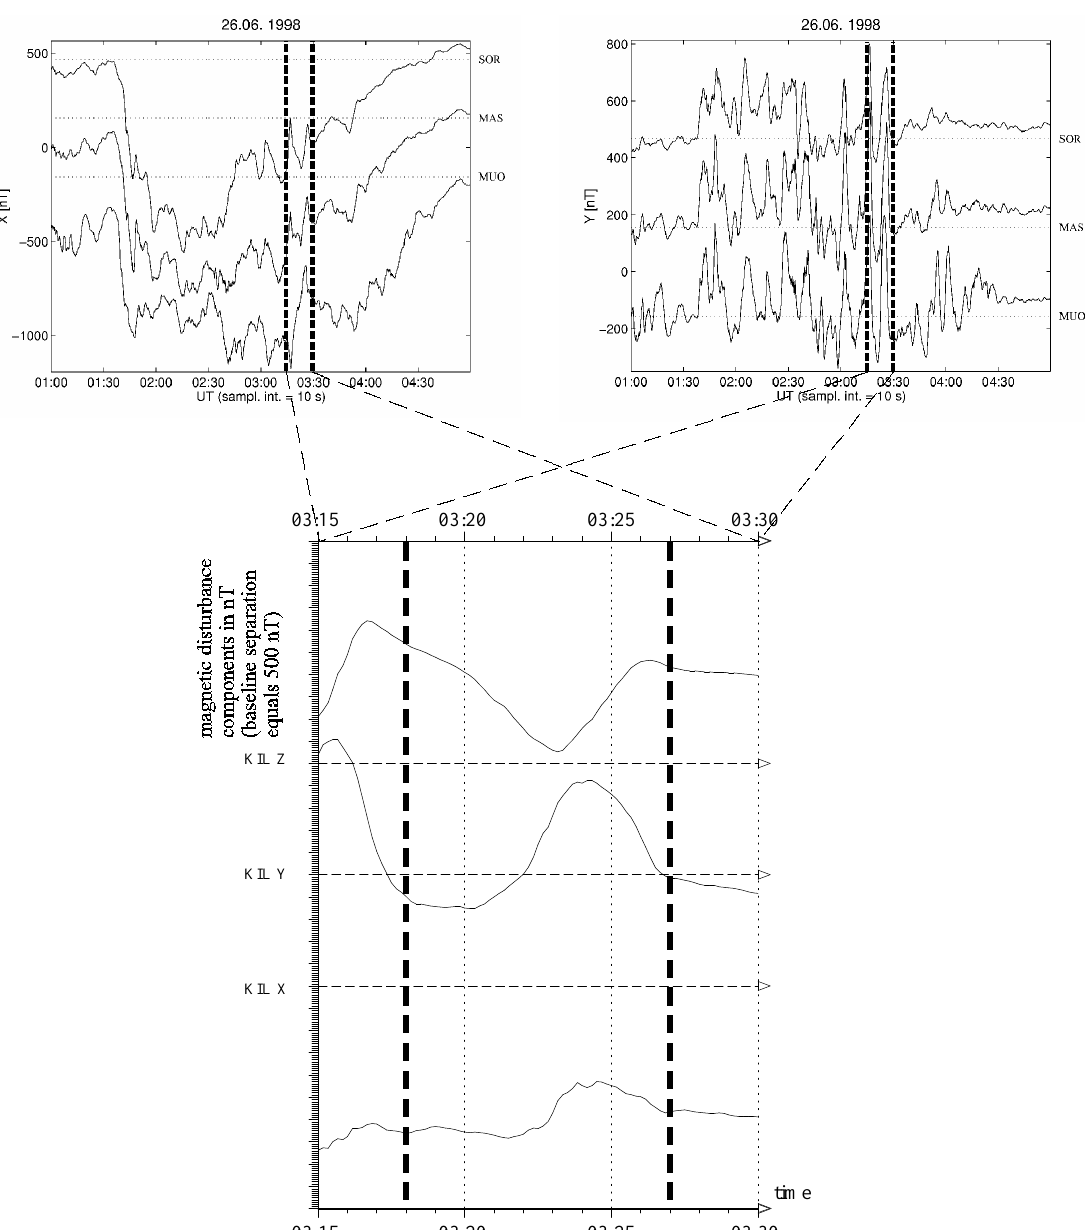
Fig. 2. Upper panels: X (northward, left panel) and Y (eastward, right panel) components of the magnetic field disturbance at three merid- ionally aligned IMAGE stations, for the whole substorm period during which the event analysed here took place; lower panel: X, Y, and Z (downward) components of the magnetic field disturbance measured at Kilpisj¨arvi (KIL) on 26 June 1998; the vertical dashed lines enclose the time interval studied in detail in this paper. In all panels, the dashed or dotted horizontal lines are the baselines for the respective magnetic disturbance